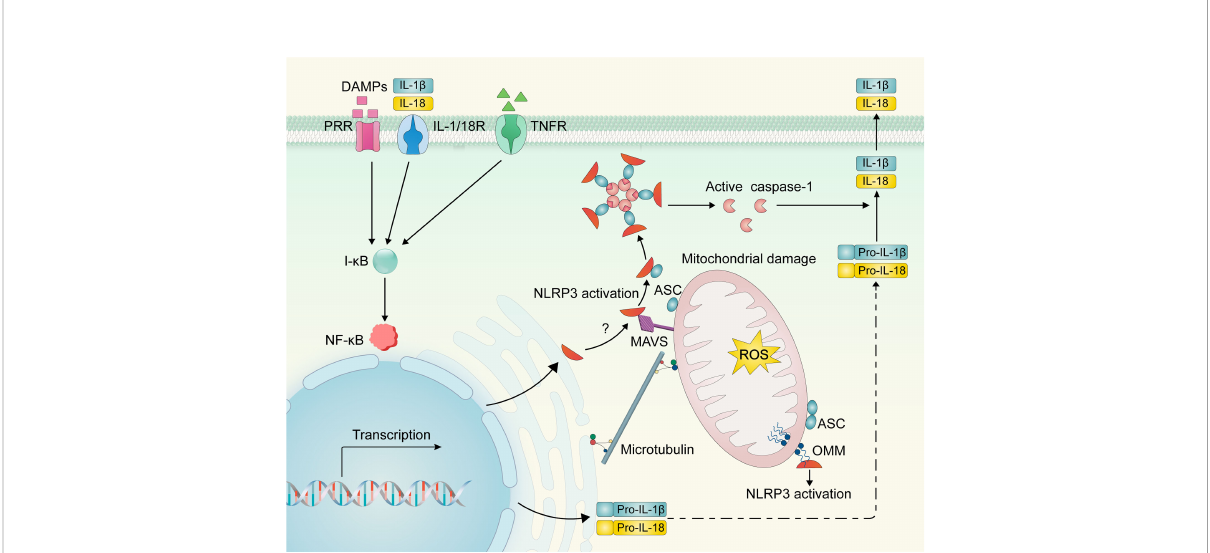
FIGURE 3 NLRP3 in fl ammasome activation. DAMPs and cytokines (e.g., IL-1 b /18 and TNF- a ) can bind to PRR and cytokine receptors, respectively, to activate the I- k B/NF- k B signaling pathway and induce NLRP3 and pro-IL-1 b /IL-18 transcriptional upregulation. Upon activation, NLRP3 may be recruited from the ER to the mitochondria and interact with mitochondrial molecules (e.g., mitochondrial antiviral signaling protein and cardiolipin). Dynein-mediated mitochondria may regulate the interaction of NLRP3 and ASC via microtubule transport, resulting in in fl ammasome assembly, caspase-1 activation, and subsequent activation of IL-1 b and IL-18. NLRP3 — NOD-like receptor family, pyrin domain containing 3; DAMPs, damage-associated molecular patterns; PRR, pattern recognition receptor; IL-1/18R, interleukin-1/18 receptor; TNFR, Tumor necrosis factor receptor; NF- k B, nuclear factor kappa B; I- k B, inhibitory protein of NF- k B; pro-IL-1 b /18, pro-interleukin-1 b /18; ER, endoplasmic reticulum; OMM, outer mitochondrial membrane; ROS — reactive oxygen species; MAMs, mitochondria associate membranes; MAVS, mitochondrial antiviral signaling protein; CL, cardiolipin; ASC, apoptosis-associated speck-like protein containing a caspase recruitment